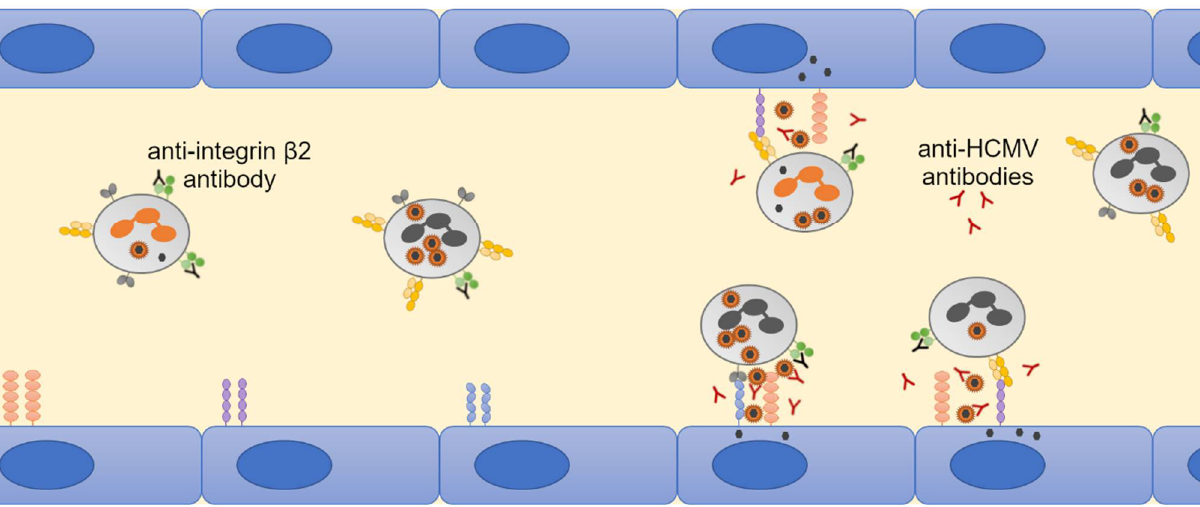
Figure 9. Hypothetical scheme of steric hindrance of neutralizing antibodies by virological synapses and enabled access by the prevented formation of virological synapses. The reaction space between PMN and endothelial cells formed by the binding of cellular adhesion molecules is referred to as a virological synapse. ( A ) As a result of this steric hindrance, large HCMV entry inhibitors such as neutralizing antibodies cannot bind to viral particles that are transferred from PMNs to the endothelial cells and thus cannot prevent infection. ( B ) If the formation of the virological synapse is prevented by function-blocking antibodies to adhesion molecules, the inhibitors can bind to transmitted viral particles and thus reduce infection. Cell and receptor size as well as expression ratios are not shown realistically but are simplified to highlight predicted interactions.